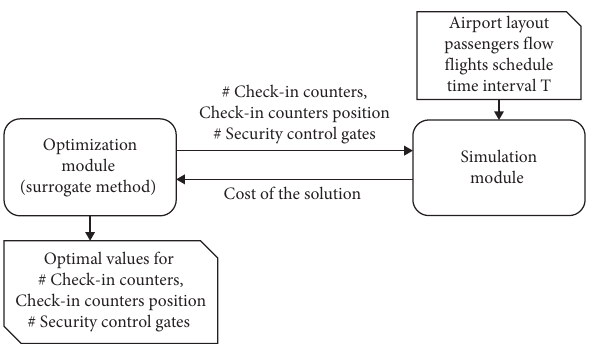
Figure 1: General schema of integration of optimization and simulation